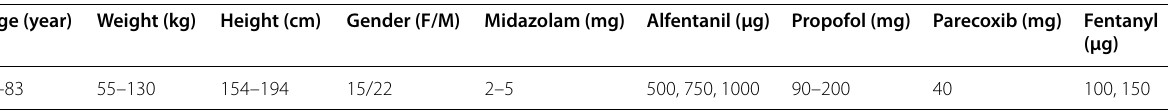
Table 1 Patient demographics and intraoperative drug usage Age (year) Weight (kg) Height (cm)